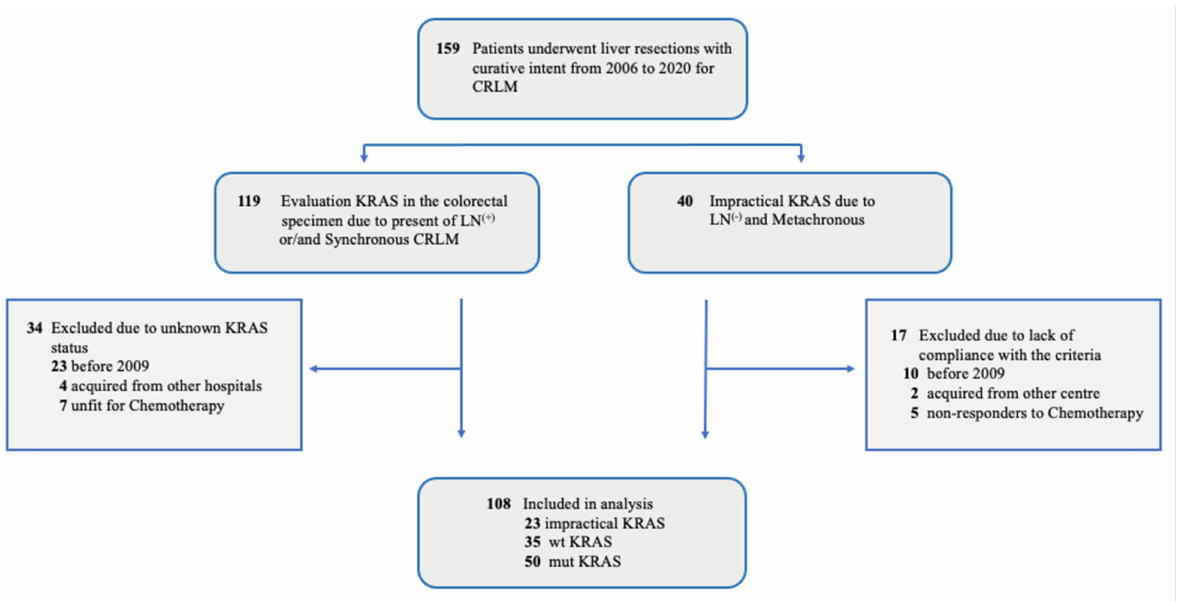
Figure 1. Study Flowchart: CRLM indicates colorectal liver metastases; LN, lymph nodes positive (+) or negative ( − ); mut KRAS, mutated genotype; wt KRAS , wild-type